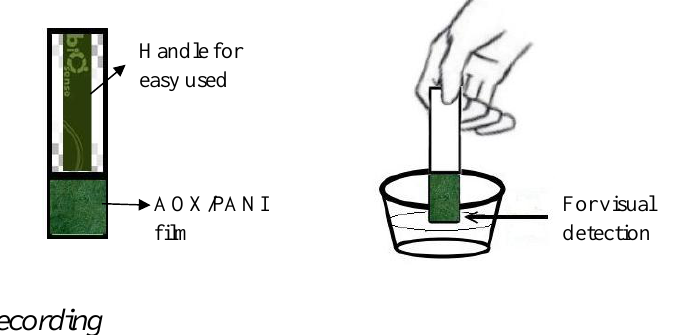
Figure 1. AOX/PANI film based biosensor design as a dip stick test ( a ) and simple used of sensor by dipped into sample solution ( b